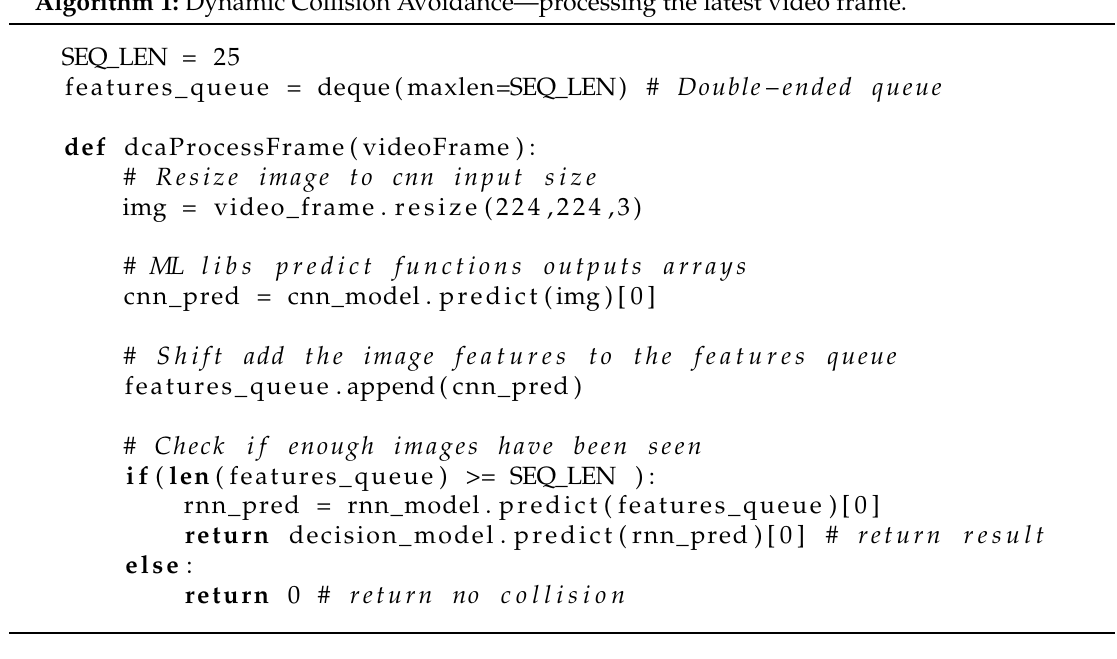
Algorithm 1: Dynamic Collision Avoidance—processing the latest video